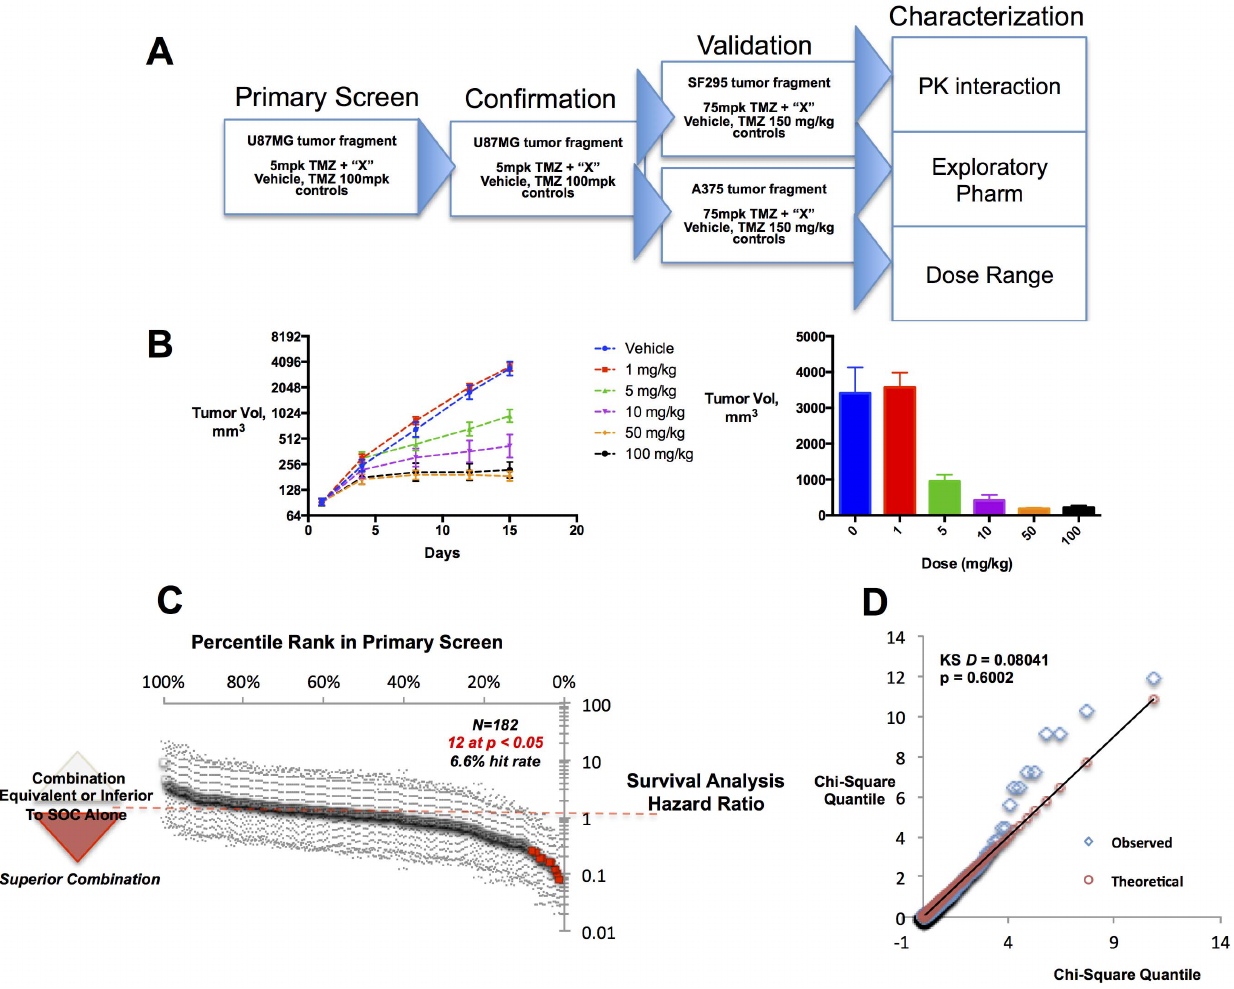
Figure 1. Experimental design, model development and screen results. A. Experimental testing funnel. Approved drugs were identified and re-confirmed in a screening model. Hits were further tested complementary models, and characterized in pilot pharmacology studies. B. U87-MG Screening Model Design and Characterization. In dose range-finding experiments, the dose level of 5 mg/kg of temozolomide was chosen as the partially effective dose that used in subsequent combination studies. C. Primary screen overview. The hazard ratios of approved drugs in survival analysis (500 mm 3 tumor burden cutoff) are plotted by rank. Two-sided confidence estimates are shown, with significant hits (N=12, Table 1) highlighted in red. D. Hit rate analysis. Experimentally observed survival analysis effect sizes (q) are plotted against the chi-square distribution; the Kolmogorov-Smirnov statistic confirms the null, that each derive from the same underlying distribution.